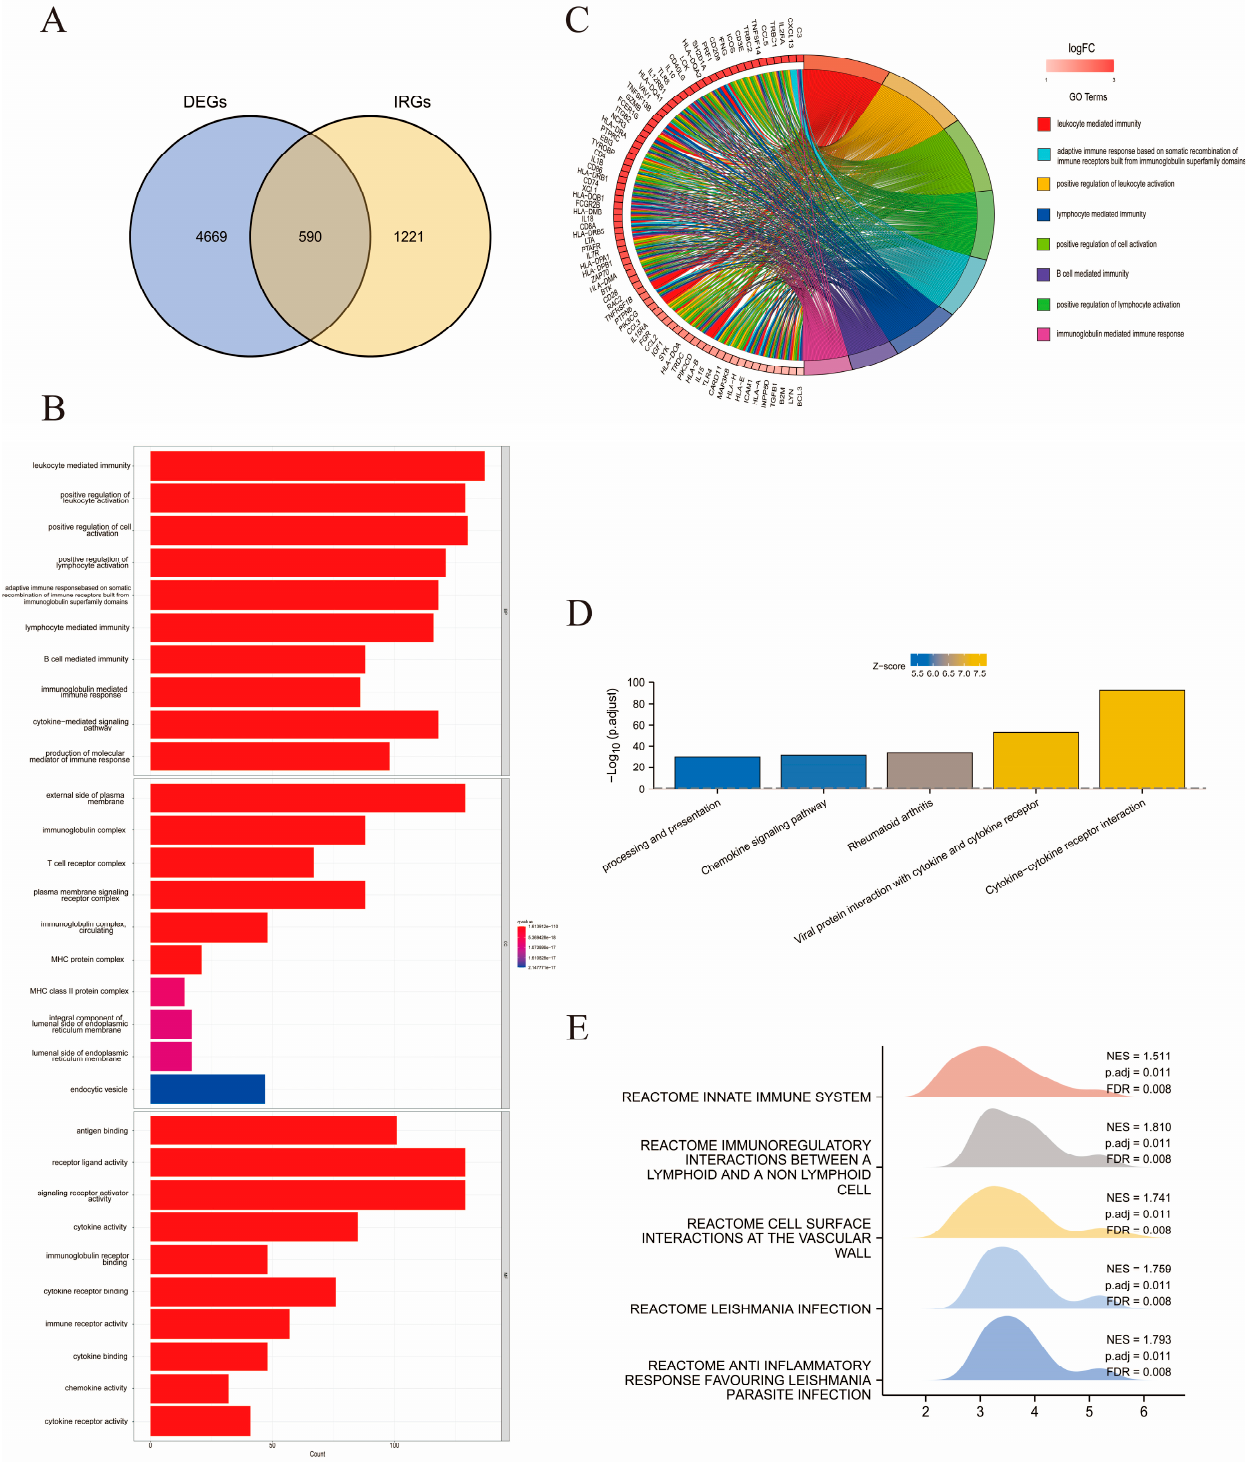
Figure 4. Identification of immune-related DEGs and enrichment analysis. ( A ) Venn gram showing the overlapping of 5259 DEGs and 1811 IRGs by 590 immune-related DEGs. ( B ) The histogram showing the top 10 enriched GO terms. ( C ) Circle graph presenting the top eight enriched GO terms. ( D ) Bar chart indicating the top five enriched KEGG pathways. ( E ) Mountain plot listing the top five pathways with the most gene enrichment according to GSEA analysis.